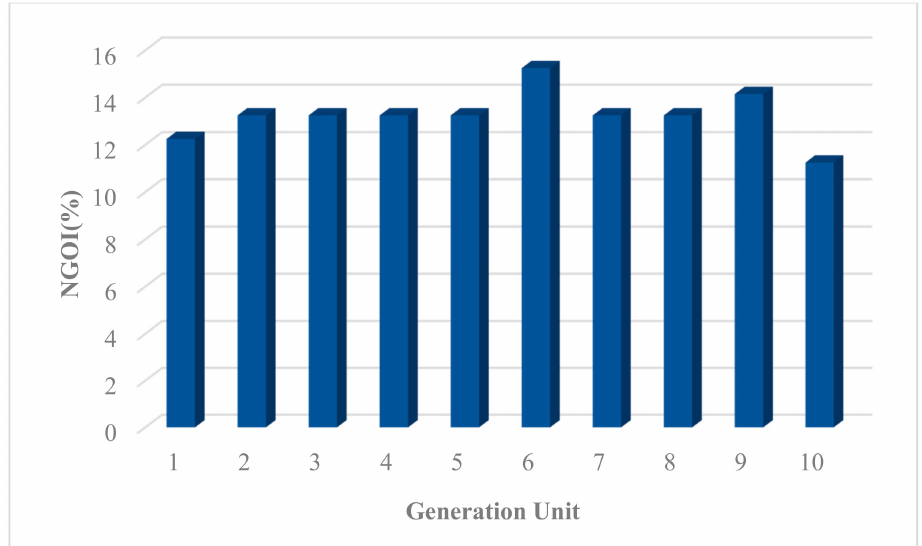
Figure 21. The vulnerability indices arising from generation unit outage in uncertainty